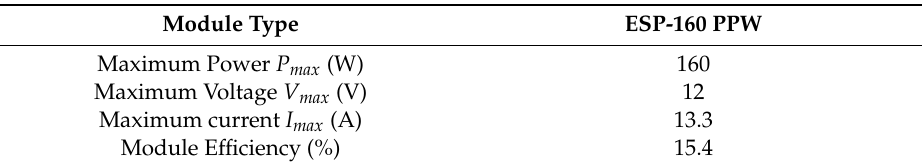
Table 2. Solar PV panels